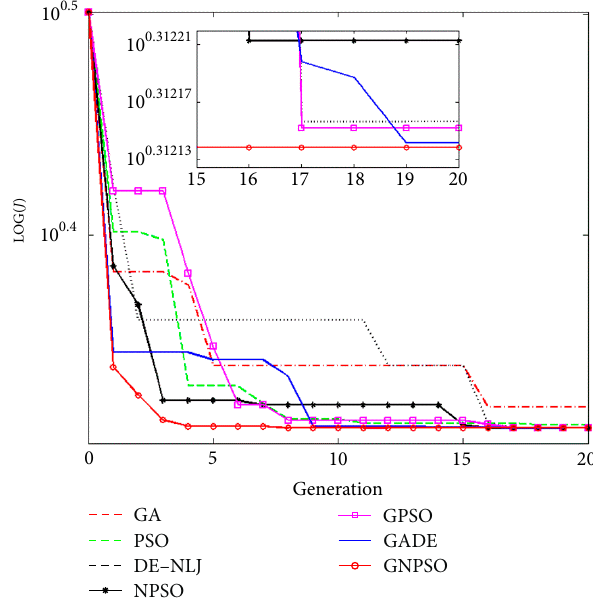
Figure 10: Comparison of convergence process of the best fitness for MIMO nonlinear wing vibration